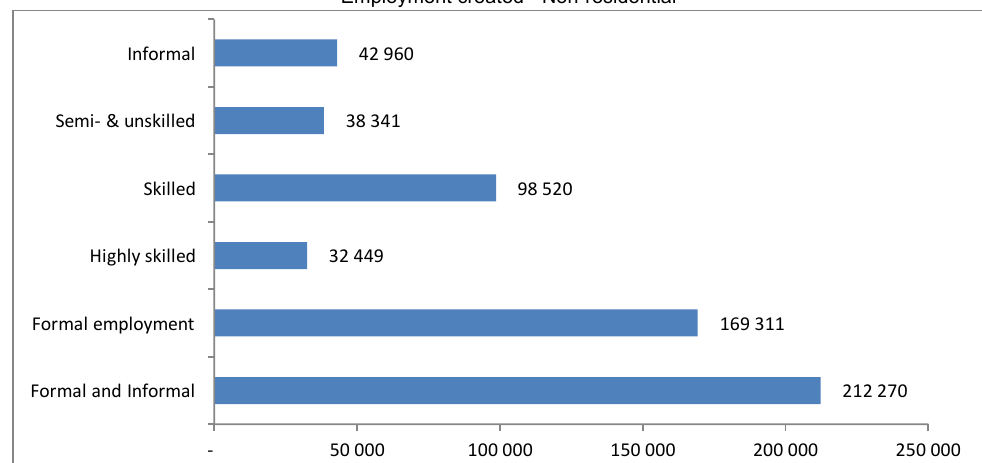
Figure 22 Employment created -